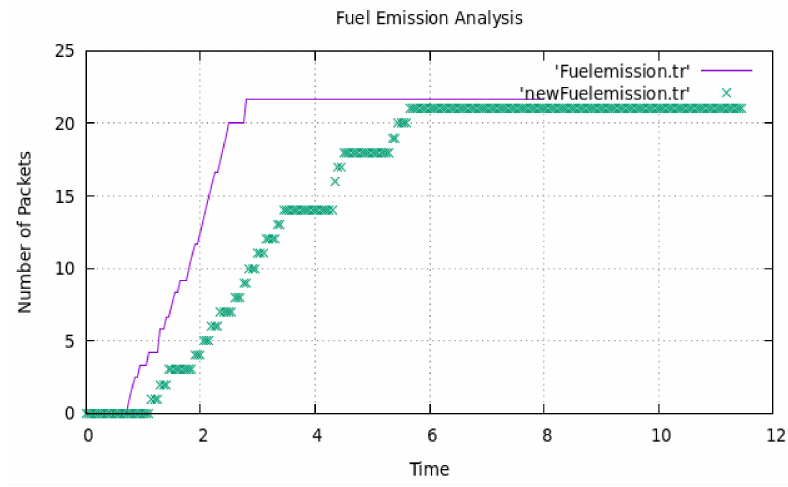
Figure 11. Fuel emission analysis of flying nodes.